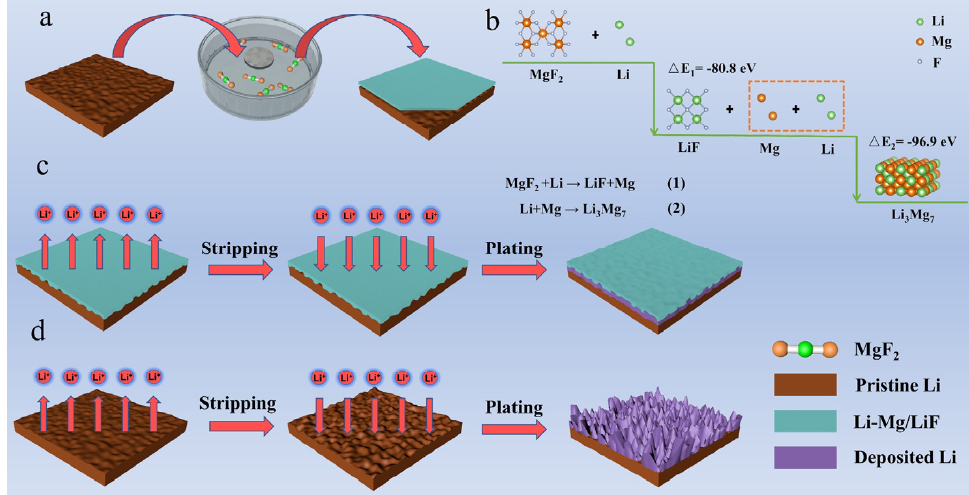
Figure 1. ( a ) Schematic for the fabrication procedure of MF-Li anode. ( b ) The enthalpy changes of chemical reactions testified by density functional theoretical (DFT) method. The morphology evolution illustration of the ( c ) MF-Li anode with MgF 2 pre-treating process, and ( d ) pristine Li.